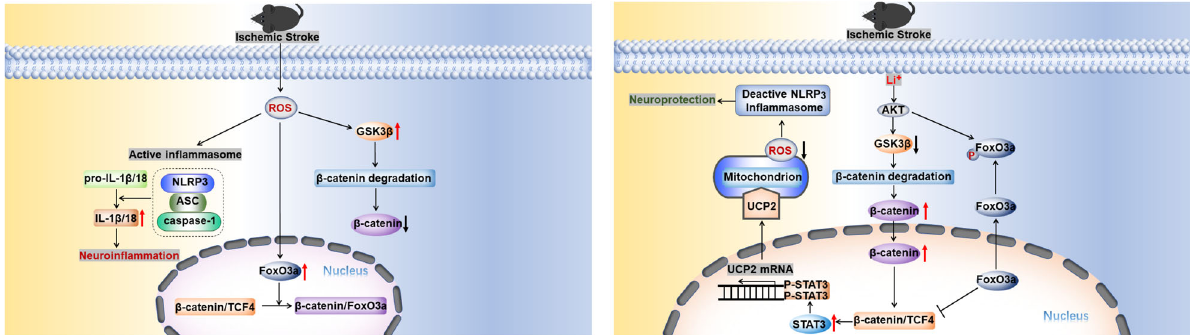
Fig. 9 Molecular pathways of Li + neuroprotection following ischaemia-reperfusion. Under the pathological condition of ischaemic stroke, LiCl inhibited the activation of GSK3 β by phosphorylating AKT, then the degradation of β -catenin was decreased, the increased β -catenin in cytoplasm more easily translocated into nucleus. As well as, LiCl increased the phosphorylation of FoxO3a by activating AKT, which promoted the more FoxO3a transportation from nucleus into cytoplasm, and the reduced FoxO3a in nucleus lacked the competition with TCF4, the increased complex level of β -catenin and TCF4 stimulated the expression and the phosphorylation of STAT3, which further induce the mRNA and protein expression of UCP2. In mitochondrion, the increased UCP2 suppressed the production of ROS and resulted in the deactivation of NLRP3 in fl ammasome stimulated by I/R injuries, in order to